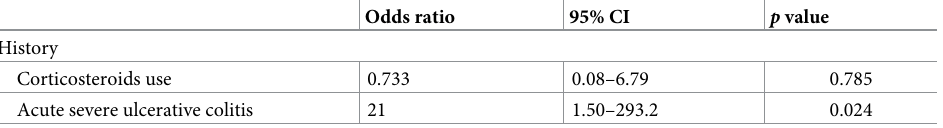
Table 3. Multivariable logistic regression analysis of independent variables associated with relapse during the 52 weeks after reducing the dose of oral